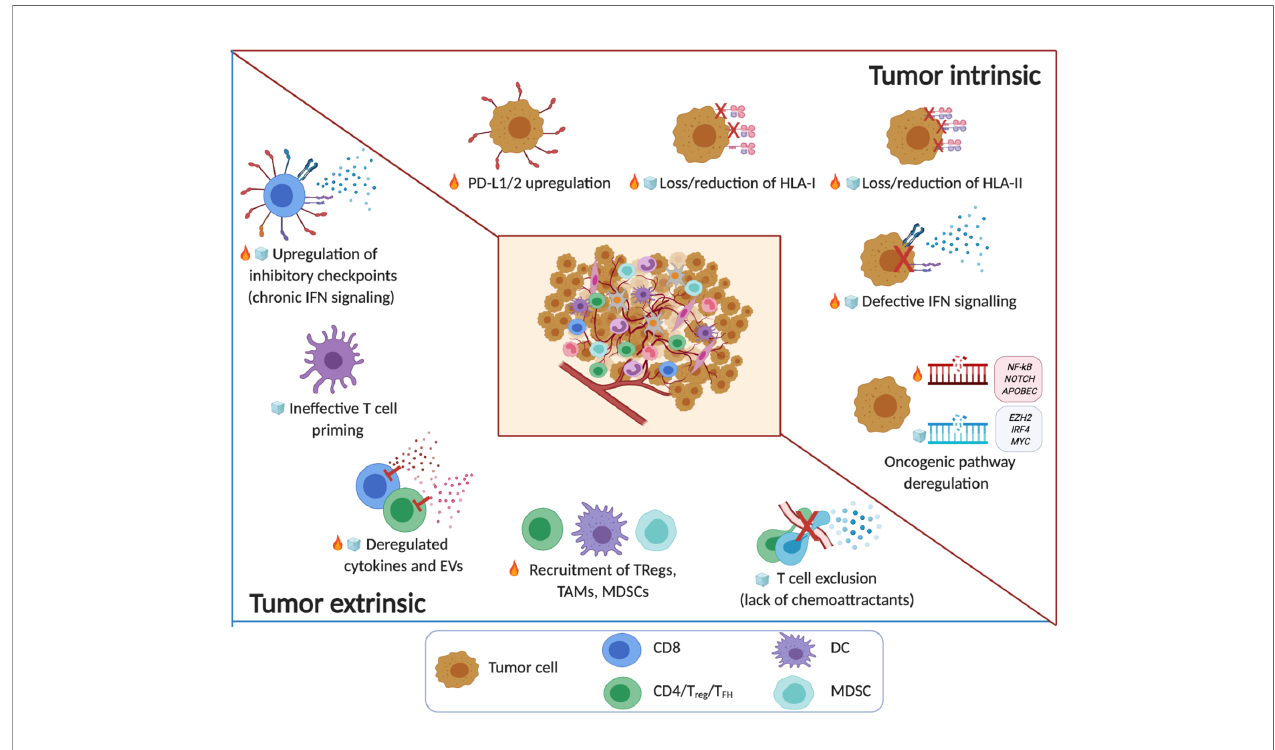
FIGURE 1 | The immune TME in B cell malignancies. Tumor intrinsic and tumor extrinsic mechanisms associated with nonin fl amed/cold ( ) or in fl amed/hot ( ) TMEs in B cell malignancy. The key factors that shape the TME include tumor immunogenicity, oncogenic pathways and genetic alterations that regulate T cell in fi ltration and function. Note: the timeline or sequence of events during the evolution of the altered pro-tumor, yet immunoprivileged TME is a current topic in the fi eld. Emerging evidence from patients treated with immune checkpoint blockade drugs suggests that cancer immunoediting takes place not only during tumor progression but also in response to therapy ( e.g. the acquisition of mutations that contribute to ‘ defective IFN signaling ’ ) (8 – 11). Several factors of immune escape and resistance to immunotherapy (innate or acquired) that have been characterized to date, can be broadly divided in tumor-intrinsic and tumor-extrinsic mechanisms. Tumor intrinsic mechanisms generally include genetic aberrations that can affect antigen recognition ( ‘ loss/reduction of HLA-I/-II molecules ’ ) (16, 115 – 119) and in fl uence immune function ( ‘ PD-L1/2 upregulation ’ ) (120 – 122) and immune contexture in TMEs ( ‘ oncogenic pathway deregulation ’ ) including neoantigen load (83, 84). Tumor cell extrinsic factors that regulate anti-tumor immunity, immune evasion or resistance to immunotherapy involve non-tumor cellular and molecular components within the immune TME including ‘ upregulation of inhibitory immune checkpoints ’ (linked to chronic IFN signaling) (123 – 125), the ‘ recruitment of TAMs, MDSCs, T Regs ’ and stromal cells, as well as ‘ deregulated cytokines and EVs ’ (126 – 130), ‘ ineffective T cell priming ’ and ‘ T cell exclusion ’ (131 – 135). ( Created with Biorender.com